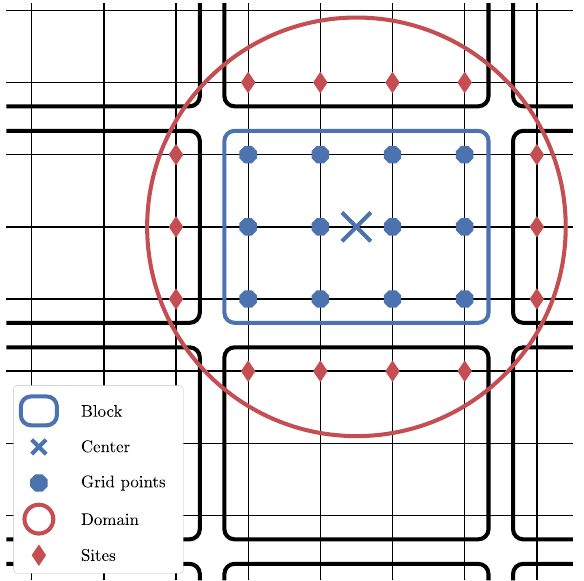
Figure 2. Example of geometry in the SBD localisation formalism for a two-dimensional space. The focus is on the block in the mid- dle, which gathers 12 grid points. The local domain is circumscribed by a circle around the block centre, with potential observation sites outside the block.